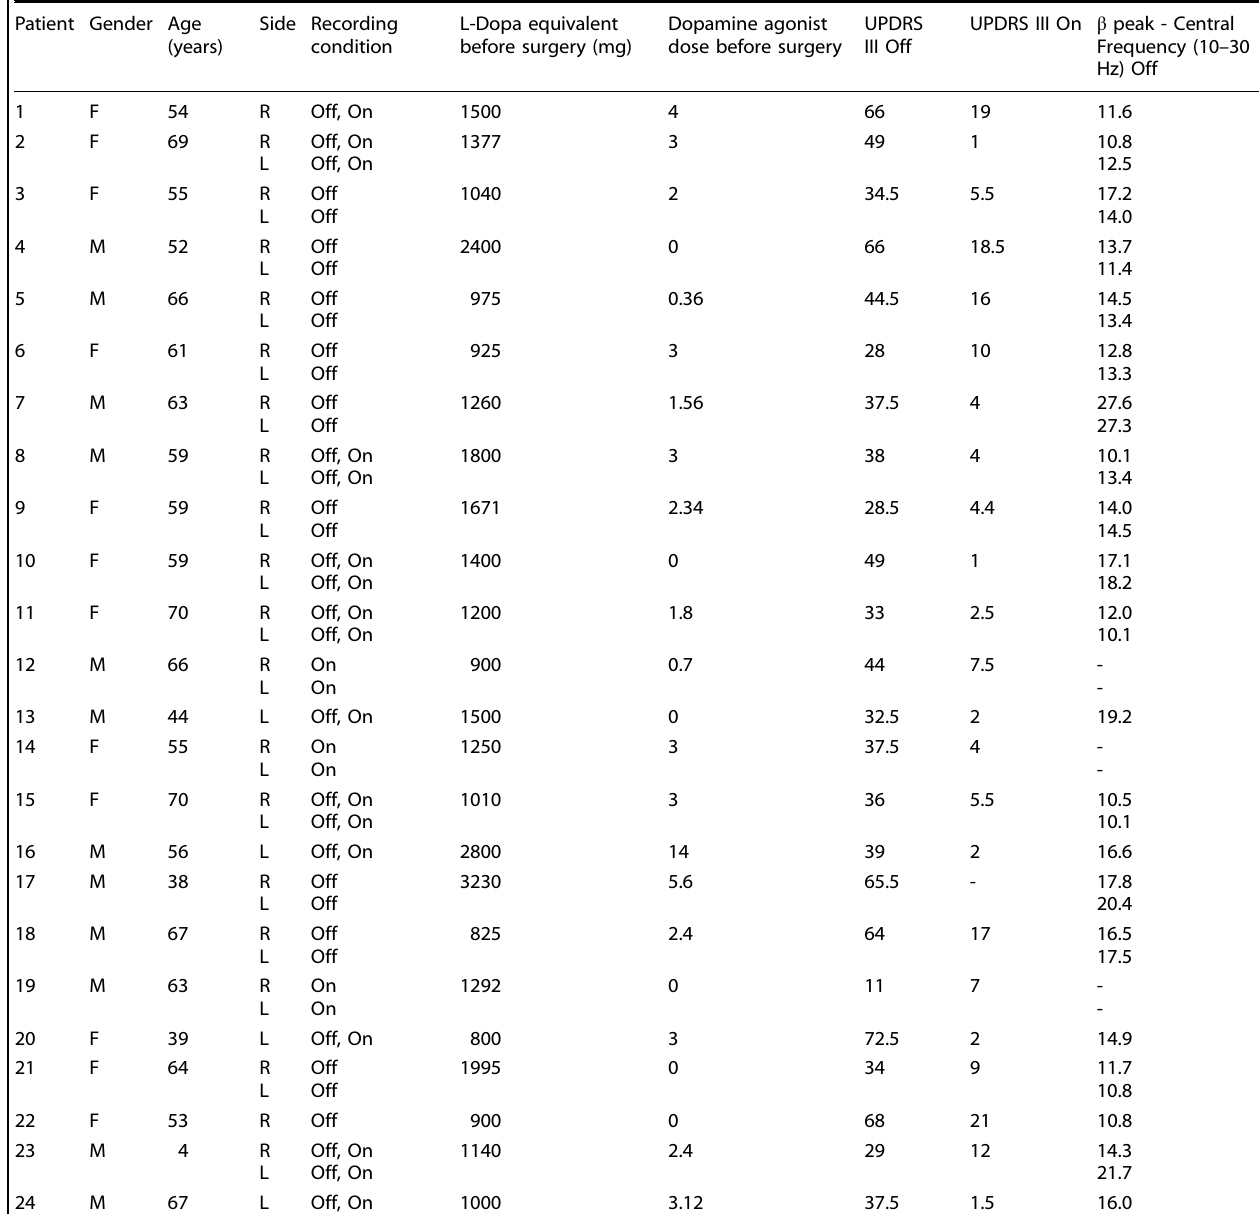
Table 1. Details of patients analyzed (24 patients, 42